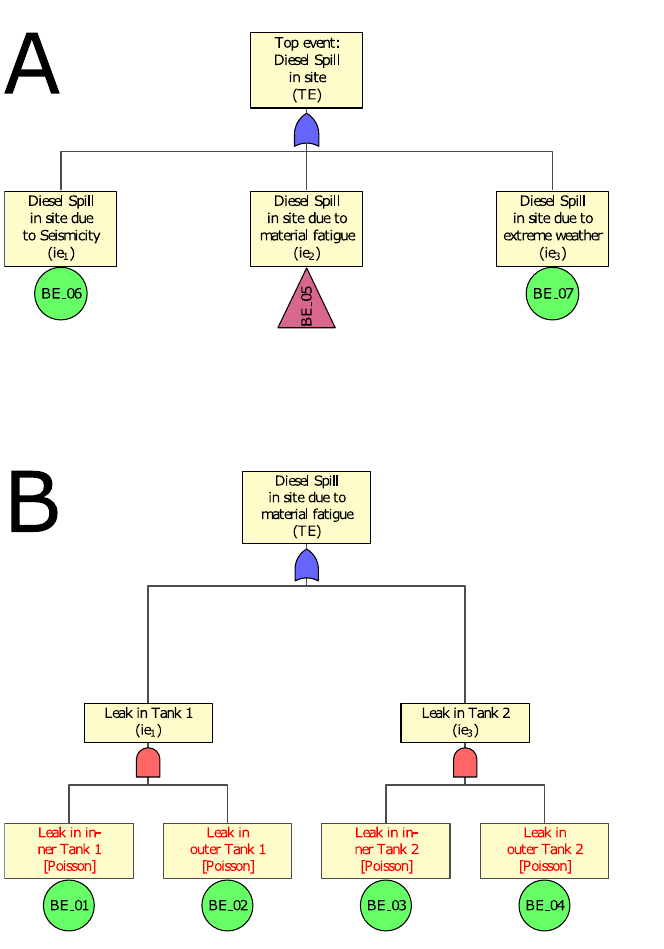
Figure 12. ( A ) Fault Tree 1 (FT1): Diesel spill on site. ( B ) Fault Tree 2 (FT2): Diesel spill on-site due to material fatigue. Table 2. Description and probabilistic models for BEs of FT2 (A) and FT1 (B).